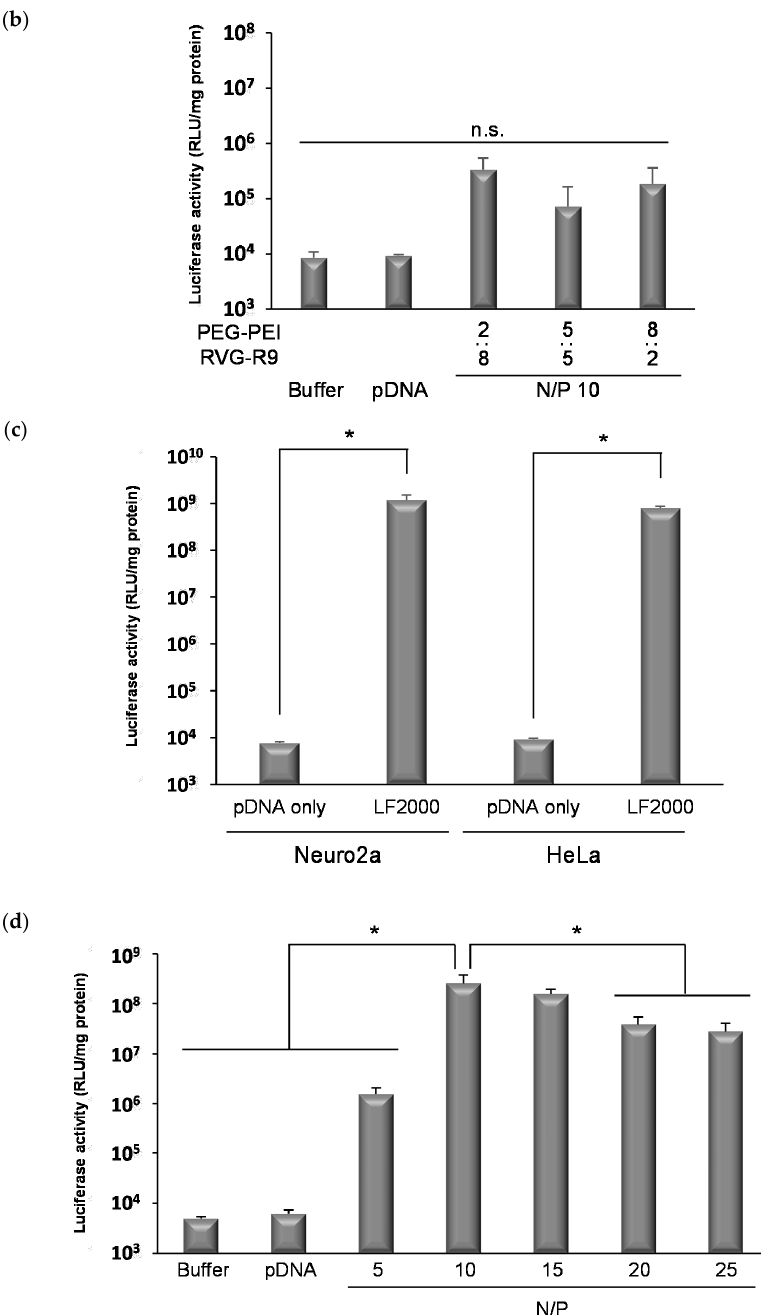
Figure 2. Gene transfection effects with various ternary complexes. Cells (5 × 10 4 cells /well) were incubated with ternary complexes containing pDNA (1 μg/well) for 4 h. Luciferase activity was analyzed 2 days after the transfection. The influence of ratio of cationic polymer in ternary complexes on the transfection in ( a ) Neuro2a cells and ( b ) HeLa cells. ( c ) Gene transfection effects with LF2000. Neuro 2a cells or HeLa cells were incubated with LF2000 complexes containing pDNA (1 μg/well) for 4 h. Luciferase activity was analyzed 2 days after the transfection. The bars show the mean and S.D. ( n = 3). * indicates p < 0.05 using an unpaired t -test. ( d ) The influence of N/P ratio of ternary complexes (PEG-PEI:RVG-R9 = 4:1) on the transfection in Neuro2a cells. The bars show the mean and S.D. ( n = 3). * indicates p < 0.05 using a one-way ANOVA with Tukey’s post-hoc test. n.s. indicates no significant